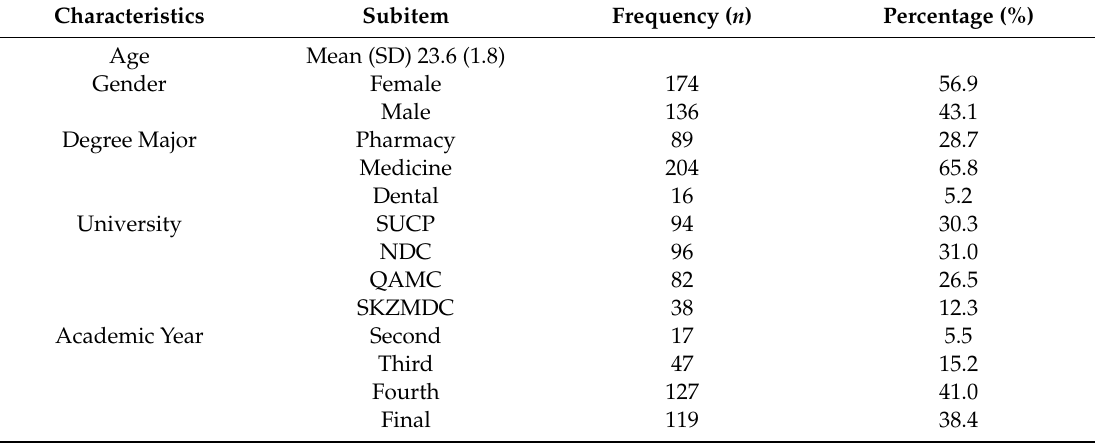
Table 1. Demographic and academic profile. SUCP: Superior University College of Pharmacy; NDC: Nishtar Dental College; QAMC: Quaid-E-Azam Medical College; SKZMDC: Shaikh Khalifa bin Zayed Al Nahyan Medical and Dental